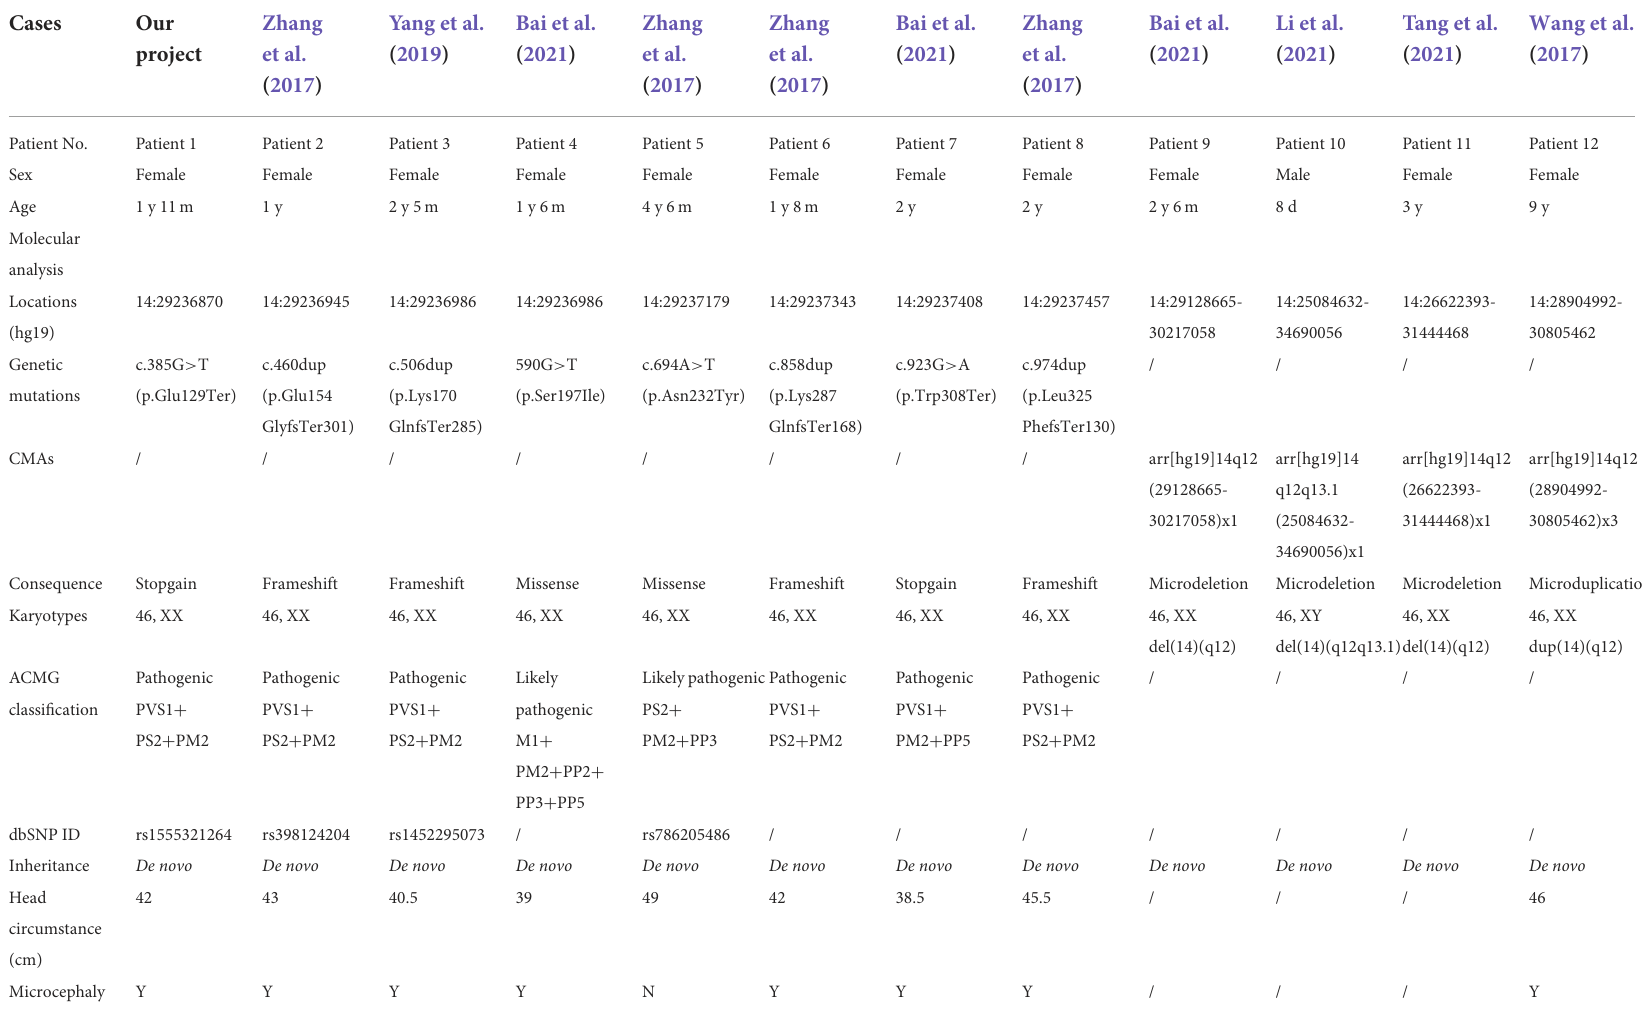
TABLE 1 Characterizations of the 12 Chinese patients with FOXG1